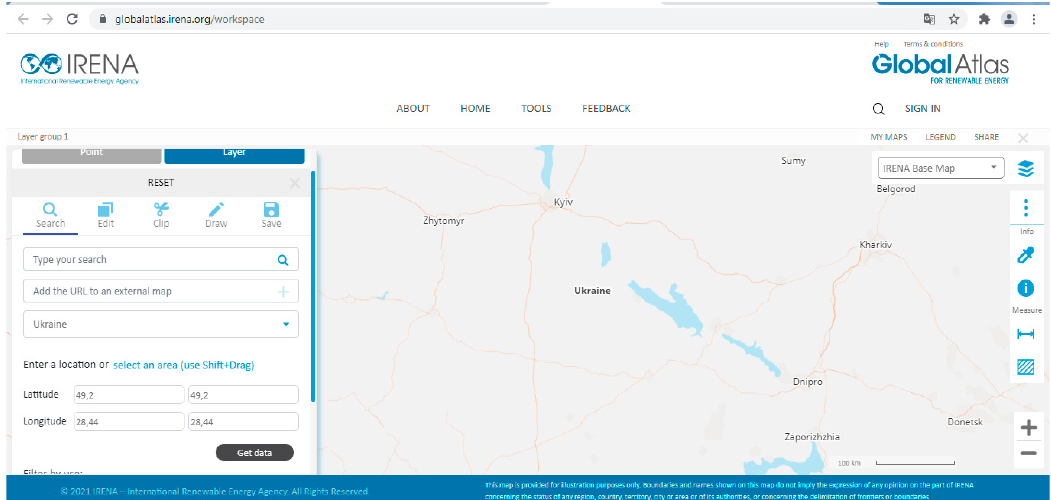
Figure 4. Selection of areas with coordinates in Ukraine to determine the characteristics of renewable energy sources in the Global Atlas program from IRENA (reproduction of graphic material from [30]).